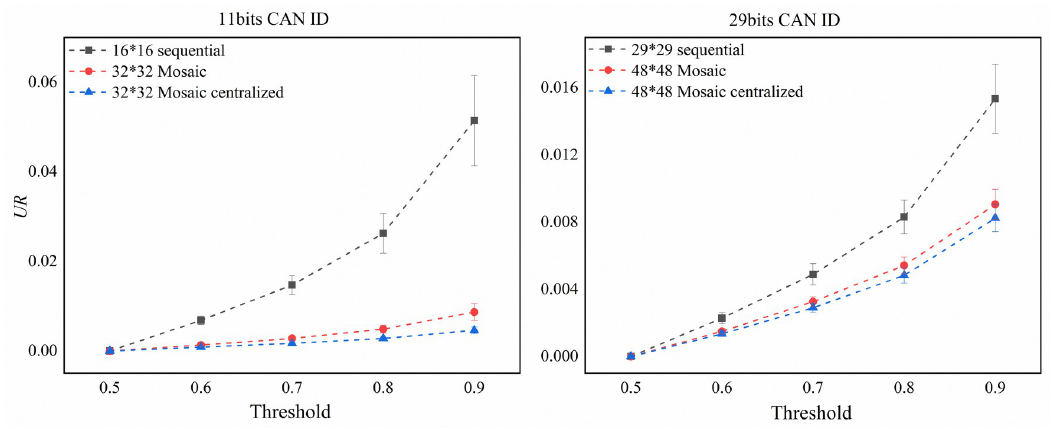
Fig 9. A comparison of UR values for the four attack types.